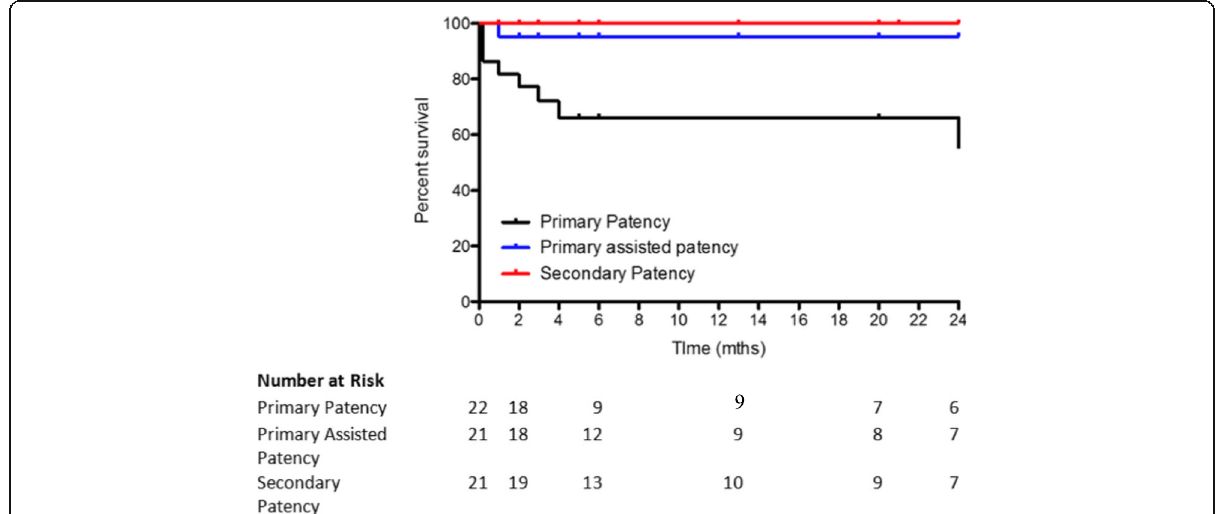
Fig. 2 Kaplan – Meier curve for venous stent